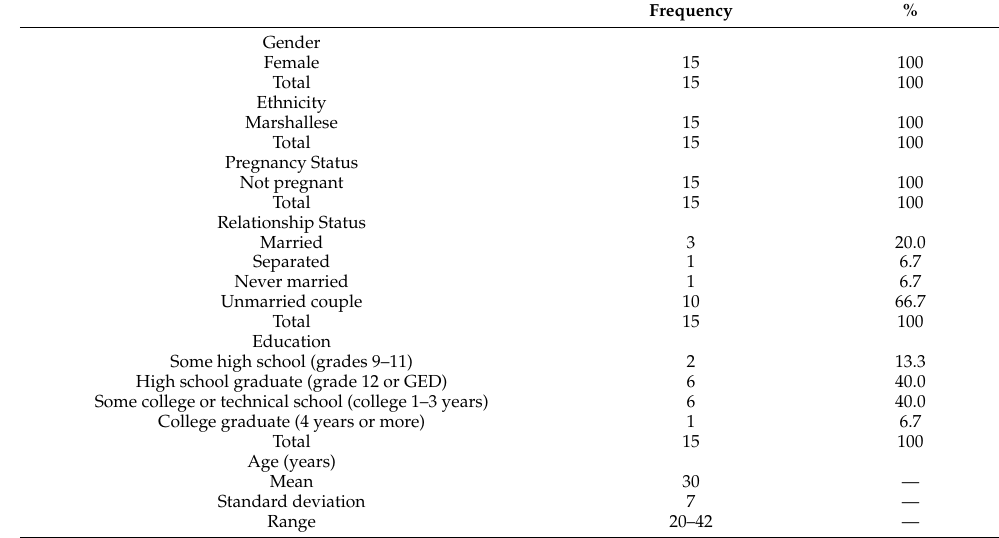
Table 1. Marshallese Mothers